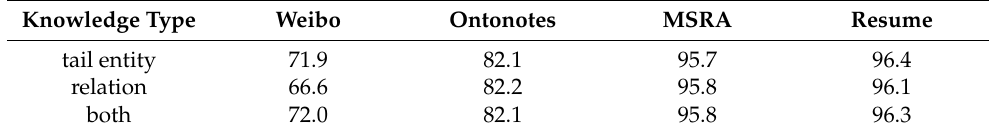
Table 3. Adding different knowledge to the sentence ( F